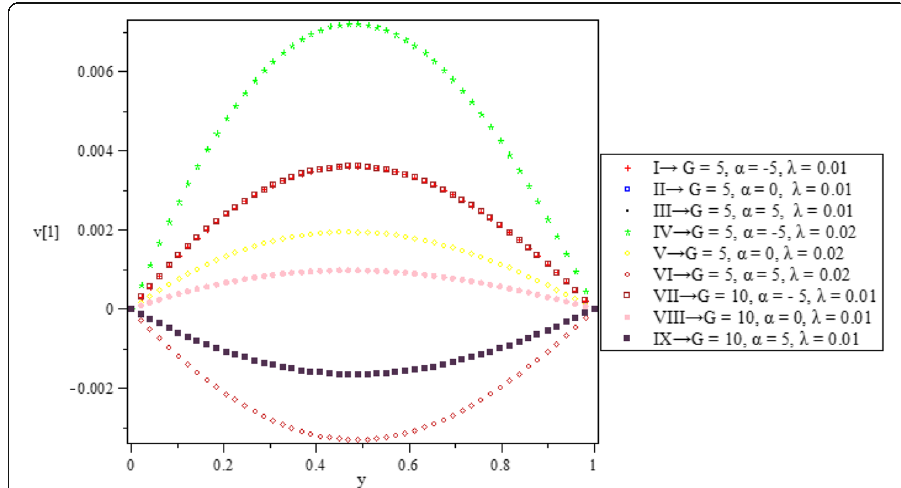
Fig. 24 First-order velocity (v[1] profile, r = − 1, ϵ = 0.25, P = 7, and β =